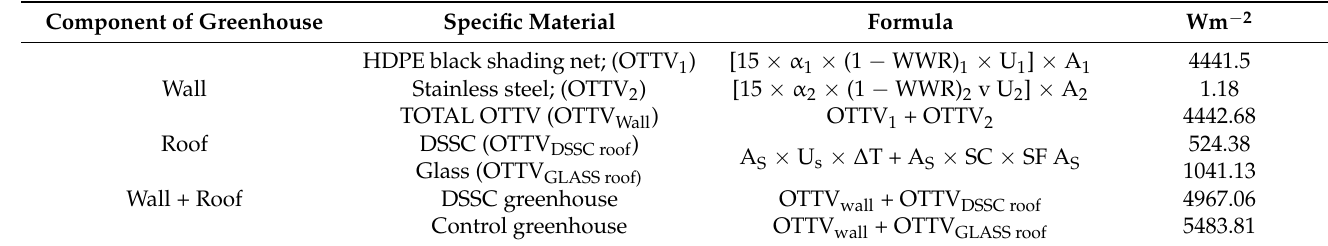
Table 4. The OTTV calculation for DSSC and control greenhouse.